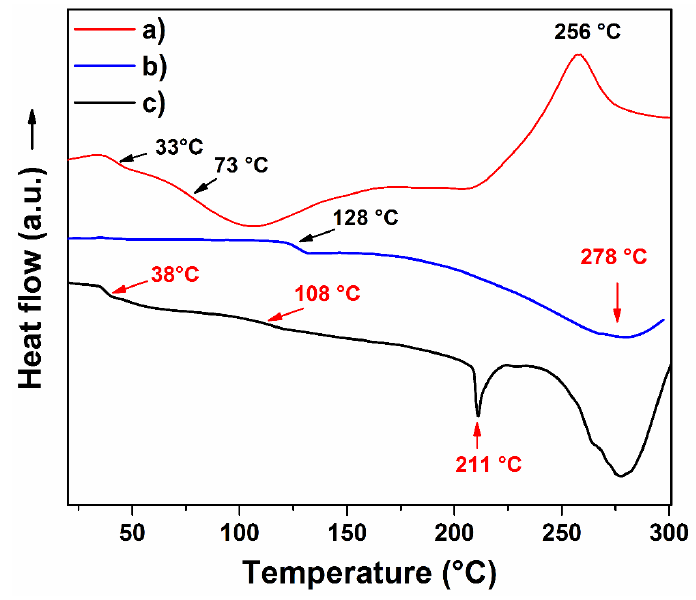
Figure 5. DSC profiles of ( a ) agar, ( b ) PAAc, and ( c ) hydrogel (hydro8).